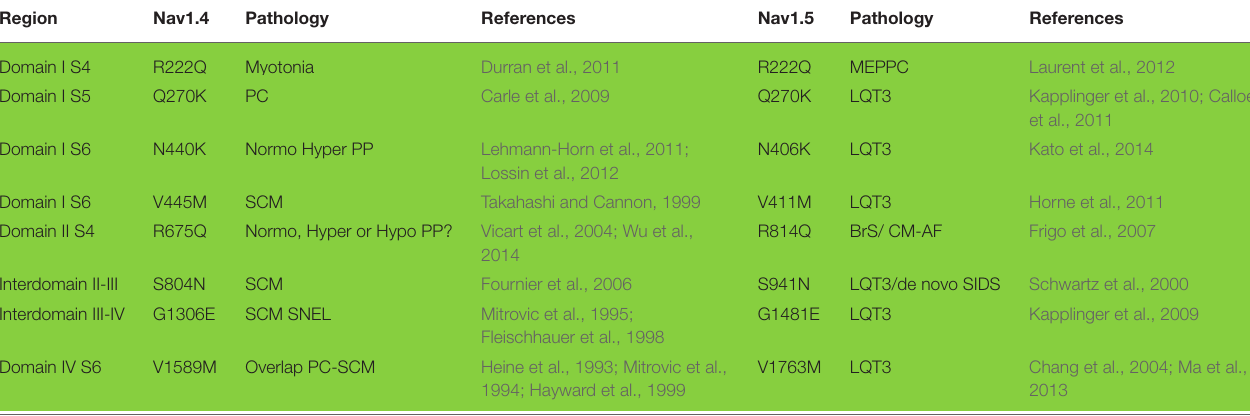
TABLE 4 | List of equivalent amino acids found to be similarly mutated in patients with cardiac (Nav1.5) or skeletal (Nav1.4) pathologies. Region